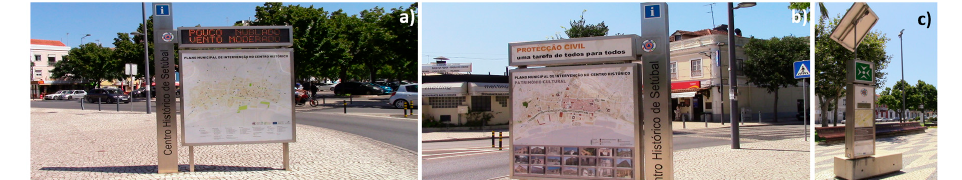
Figure 2. Information panels installed by the SMPCB in the urban area: ( a ) Front of electronic panel; ( b ) Back of an electronic panel; ( c ) Emergency column.